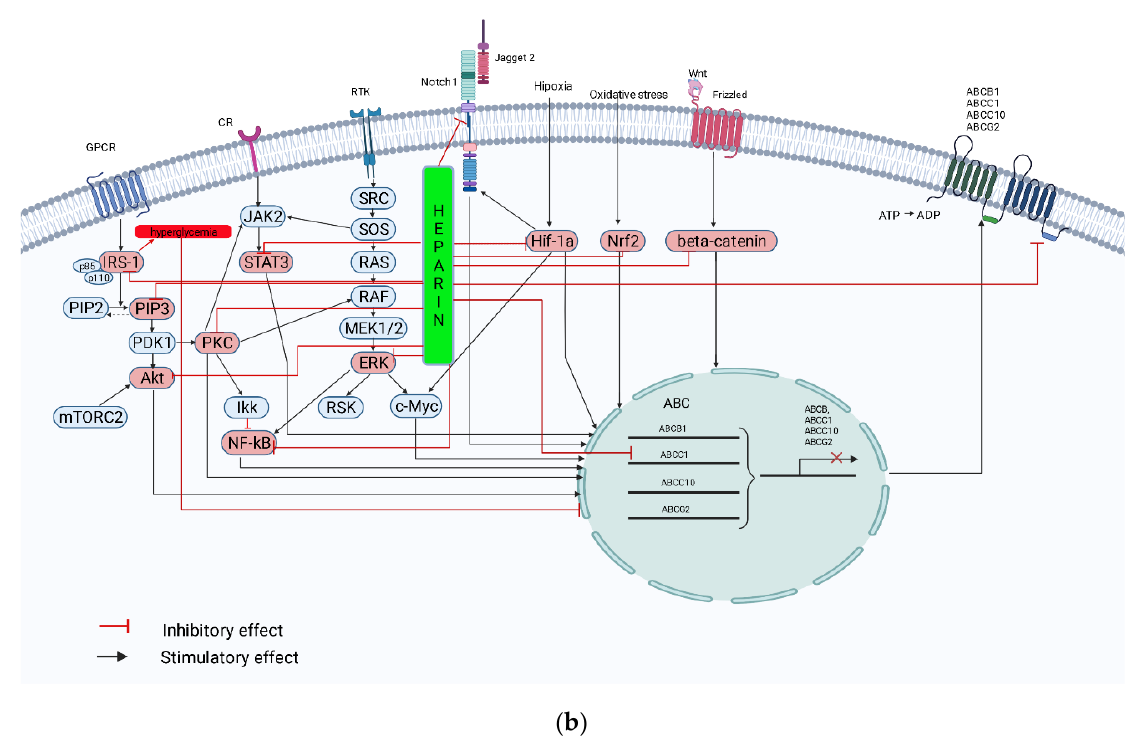
Figure 2. Molecular mechanisms of the influence of heparin on the signaling pathways responsible for the development of multidrug resistance in tumor and immune cells. ( a ) 1-Activation of GPCR (G protein-coupled receptors) induces the PI3K/Akt (phosphatidylinositol 3-kinase) signaling pathway in OS. In addition, OS activates IRS (insulin receptor substrate). 2-Cytokines interact with CR (cytokine receptors) and activate JAK2/STAT3 signaling pathway. 3-Hyperactivation of growth factor-related signaling pathways (RTK (receptor tyrosine kinase) and downstream effectors such as Ras and Raf) is a common event in humans OS. NF-kB is also activated at OS. 4-High expression of the Notch1 receptor and its ligand Jagged2 is observed on OS. 5-Tumor cell development occurs under hypoxia conditions. High expression of the transcription factor HIF-1a is observed in the cells. 6-Reactive oxygen and nitrogen species cause oxidative stress. Nuclear Factor Erythroid 2-Related Factor 2 (Nrf2) is a novel regulator of cellular resistance to oxidants. Overexpression of Nrf2 is observed at OS. 7-The Wnt/beta-catenin signaling pathway controls important cellular processes, including cancer. 8-All of the above events affect the transcription of genes that are resistant to multiple drugs. 9-Cancer cells are characterized by high expression of multidrug resistance proteins. ( b )